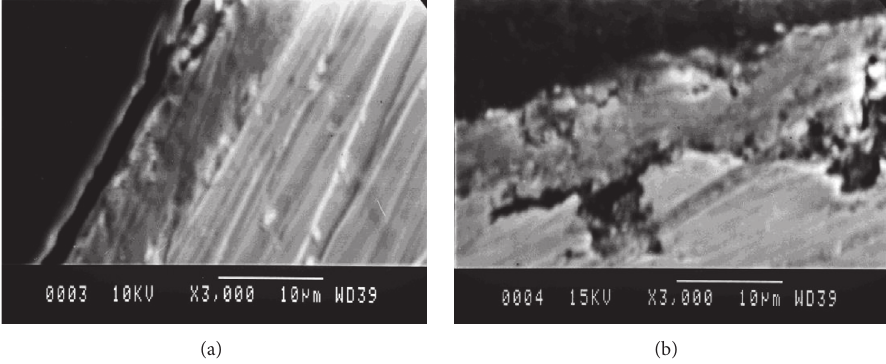
Figure 7: SEM images of corrosion products and deposit on the surface of (a) reheater and (b) superheater tubes.